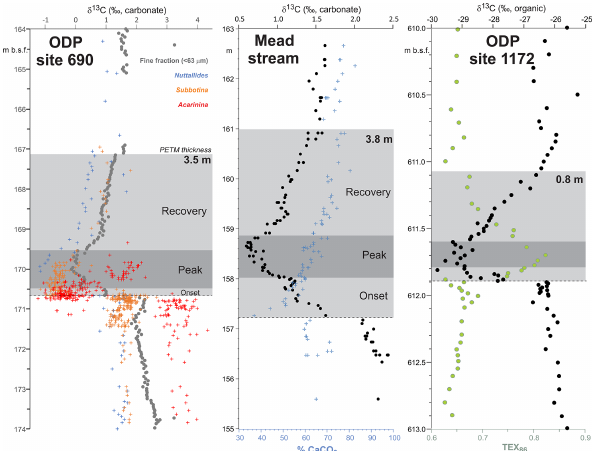
Figure 2. Three high-resolution records through the Paleocene– Eocene thermal maximum (PETM): ODP Site 690, Maud Rise, South Atlantic (Kennett and Stott, 1991; Bains et al., 1999; Thomas et al., 2002; Nunes and Norris, 2006); Mead Stream, New Zealand, South Pacific (Nicolo et al., 2010); ODP Site 1172, East Tasman Plateau, Tasman Sea (Sluijs et al.,